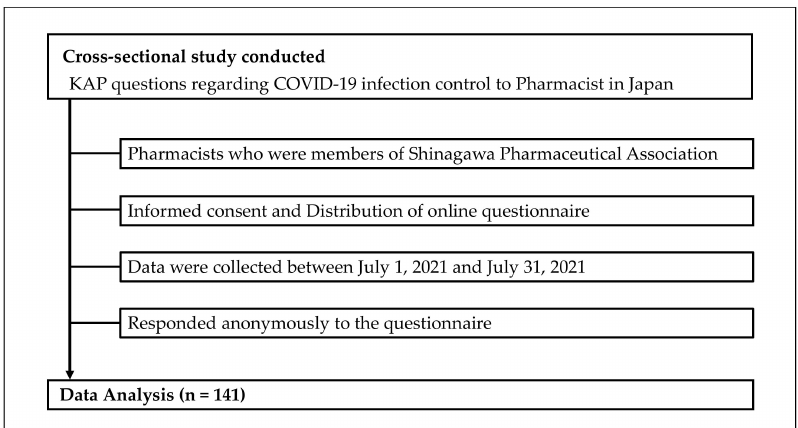
Figure 1. Flowchart of the cross-sectional